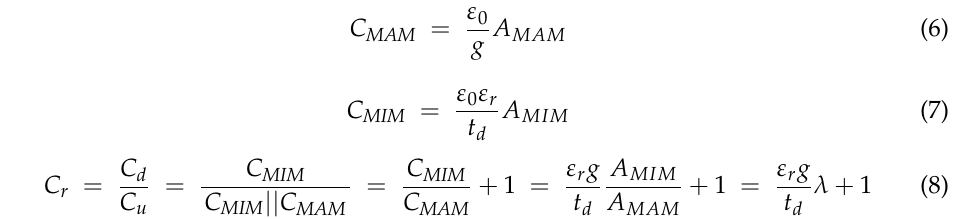
Figure 5. Circuit topology of the proposed MEMS switch with MIM capacitors.